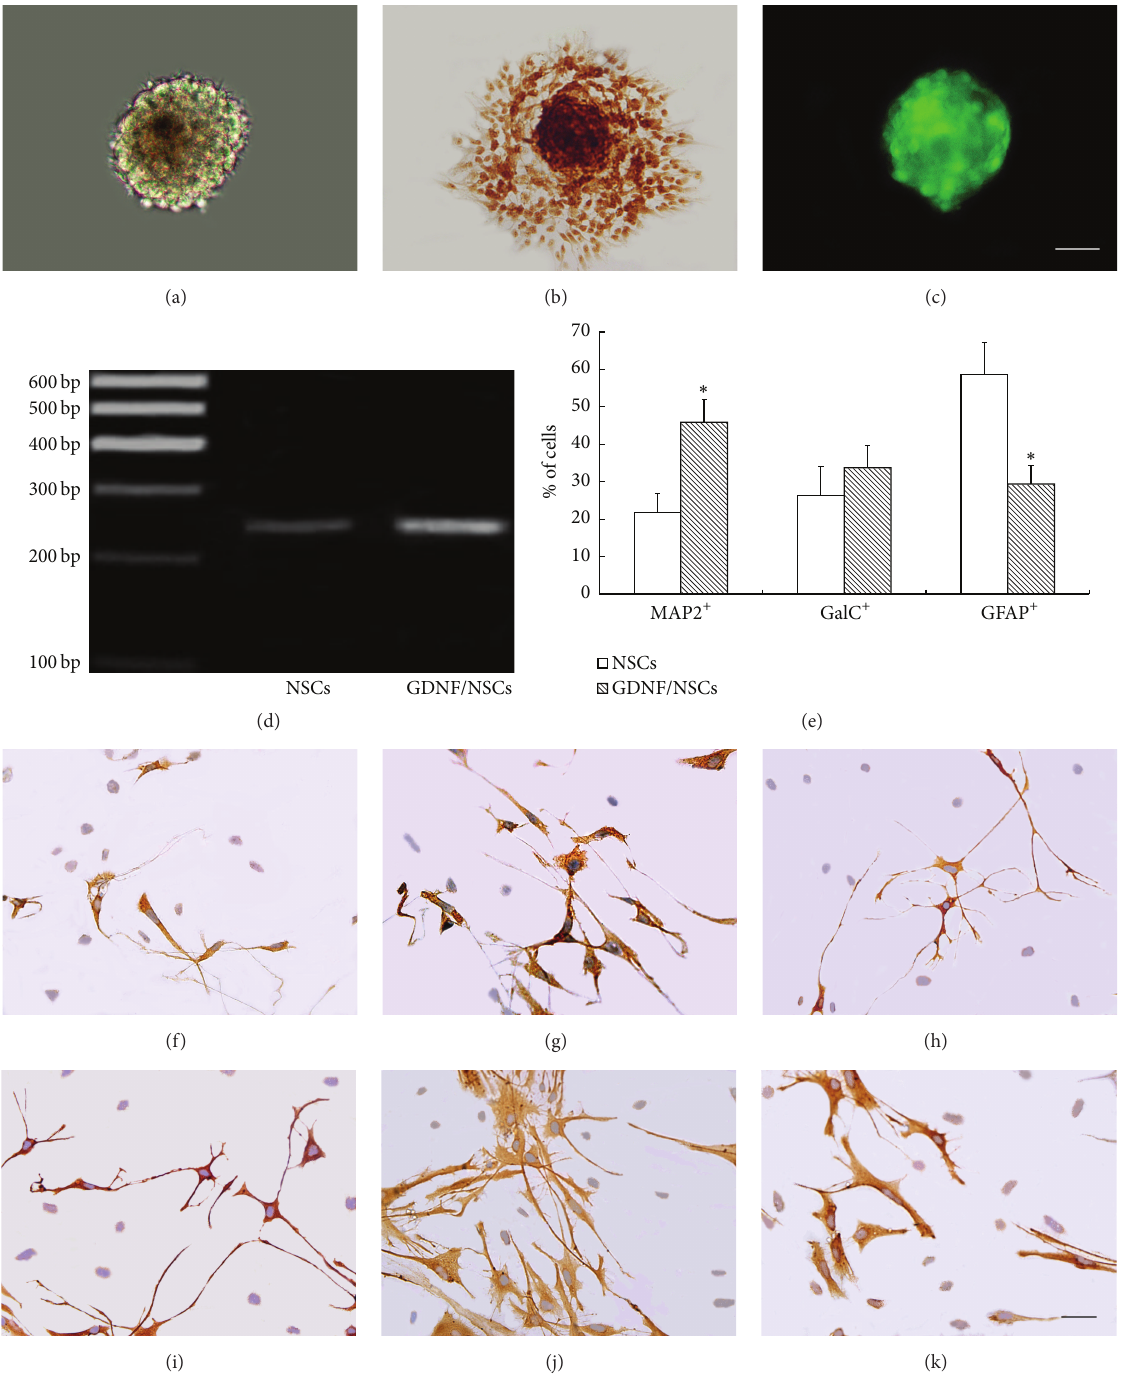
Figure 1: The generation and characterization of the neurosphere in vitro . (a) Cultured neurospheres derived from cerebral tissue of newborn rats at culture of 7d. (b) Immunocytochemical staining of nestin in neurospheres. (c) Neurospheres infected by GDNF recombinant adenovirus for 2 days showed green fluorescence under fluorescence microscope. (d) RT-PCR showed higher level of GDNF mRNA in the GDNF/NSCs than NSCs. (e) Quantitative analysis of the percentages of NSCs and GDNF/NSCs differentiated into each type of neural cells (mean ± SD, 𝑛 = 5 ). ∗ Compared with NSCs group, 𝑃 < 0.05 . (f–k) Immunostaining showed, respectively, MAP2, GalC, and GFAP-positive cells from neurospheres. (f) MAP2 + cells from NSCs; (g) MAP2 + cells from GDNF/NSCs; (h) GalC + cells from NSCs; (i) GalC + cells from GDNF/NSCs; (j) GFAP + cells from NSCs; (k) GFAP + cells from GDNF/NSCs; (a–c) bar = 50 𝜇 m; (f–k) bar = 75 𝜇